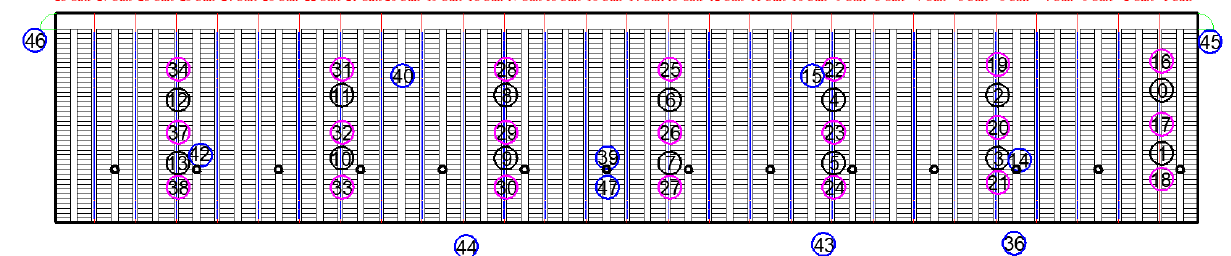
heads. Sensor nodes were placed at a height of 150 cm in cells 5, 10, 15, 20, and 25 to in heat and gas concentration above the pigs’ tails. At the same time, two wireless sensor monitor the changes in heat and gas concentration above the pigs’ tails. At the same time, nodes were placed outside the piggery and behind the wet curtain. two wireless sensor nodes were placed outside the piggery and behind the wet curtain.